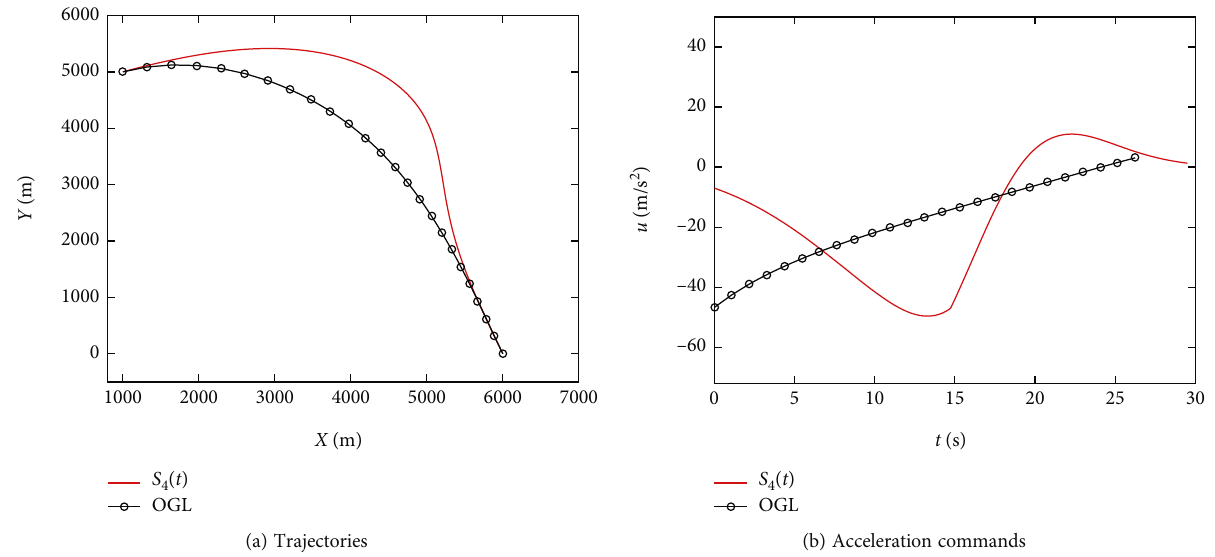
Figure 15: The comparison results of di ff erent weighting functions for γ